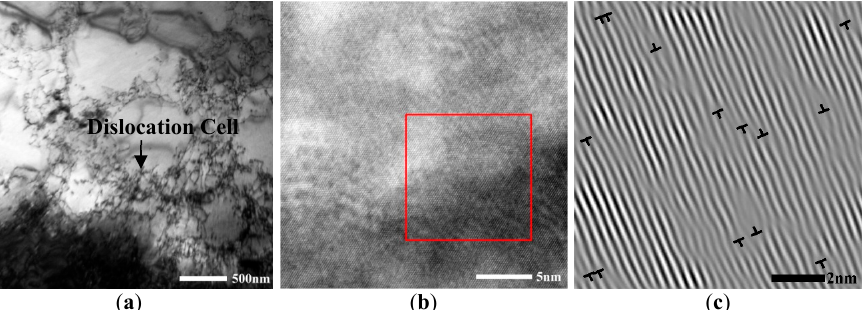
Figure 1. TEM of the alloy after solution treatment: ( a ) Bright-field image; ( b ) HRTEM image; ( c ) IFFT image of the red selected area in ( b ).